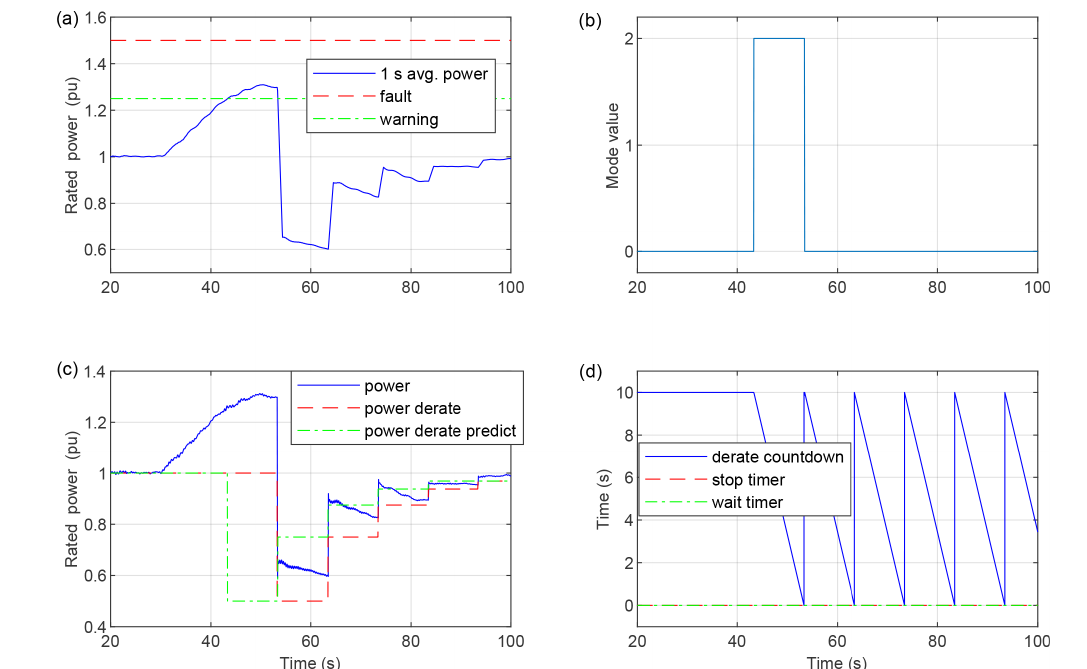
pu) while staying 32